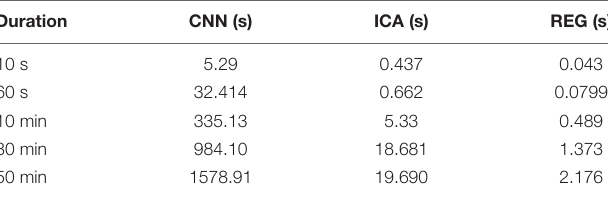
TABLE 8 | Real signal cleaning times using CNN, ICA, and